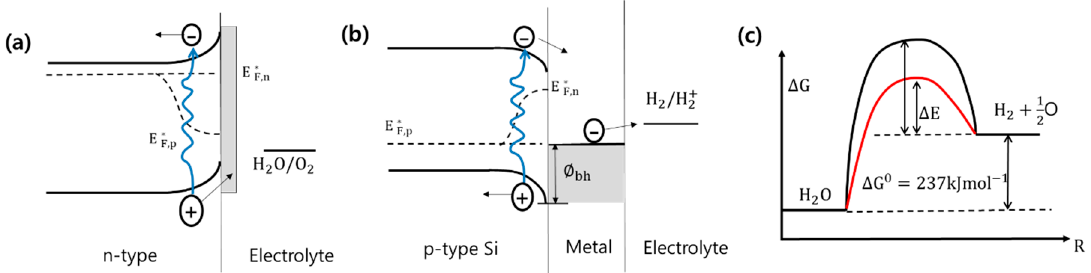
Figure 4. Energy diagram showing the roles of catalysts on Si in PEC performance. ( a ) Surface passivation of the semiconductor to reduce surface recombination. ( b ) Metal–semiconductor (MS) junction to enhance the electric field within the depletion region. Φ ph denotes the barrier height of Schottky junction. ( c ) Energy diagram for photocatalytic water splitting. ∆ G o denotes the energy required for the uphill reaction.